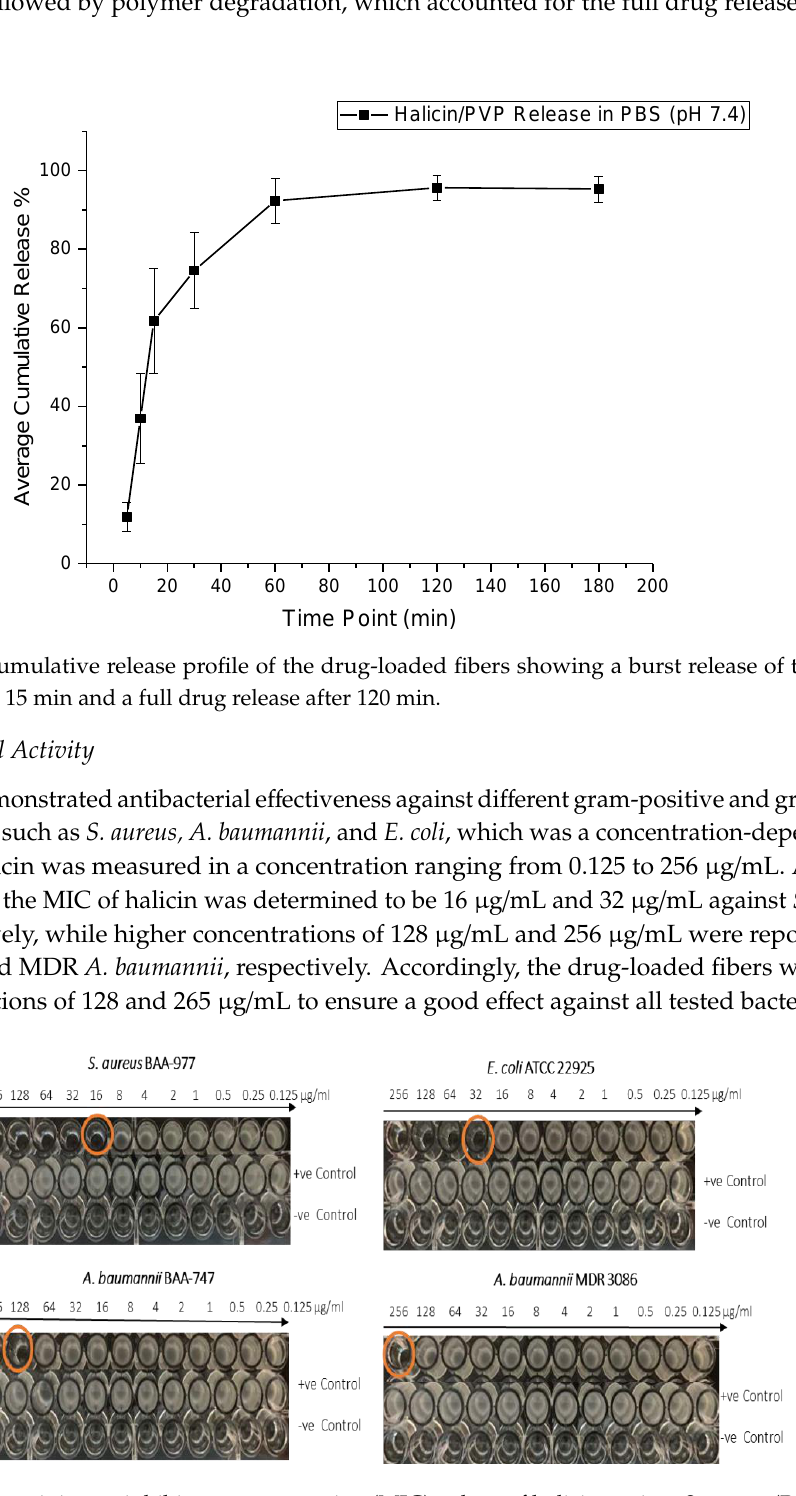
Figure 8. The minimum inhibitory concentration (MIC) values of halicin against S. aureus (BAA 977), E. coli (ATCC 22925), A. baumannii (BAA 747), and A. baumannii (MDR 3086), in which the minimum concentration (orange circled) is defined as the lowest concentration of no bacterium growth. The MIC was found at 16 μg/mL, 32 μg/mL, 128 μg/mL, and 256 μg/mL against S. aureus , E. coli , A. baumannii , and MDR A. baumannii , respectively.